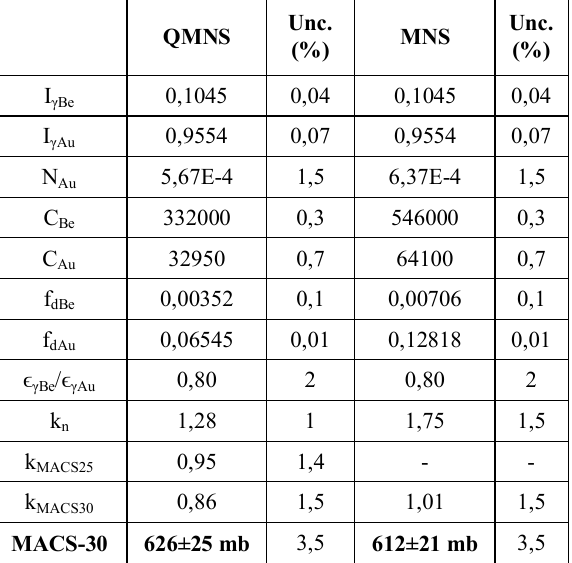
Unc. Unc. QMNS MNS